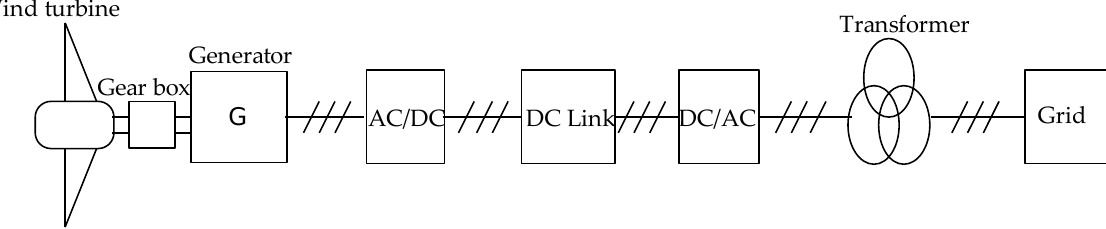
Figure 1. Main components of grid-connected wind energy sources .